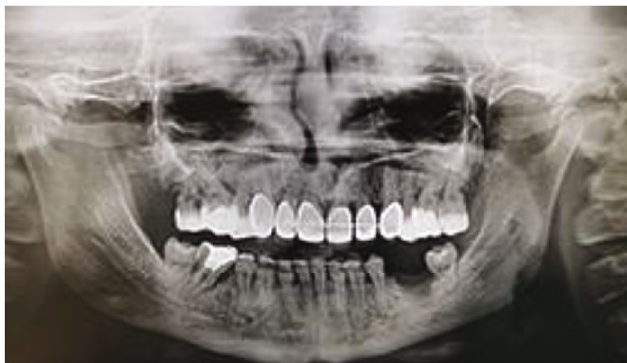
Figure 8: Panoramic radiograph on a follow-up appointment after 24